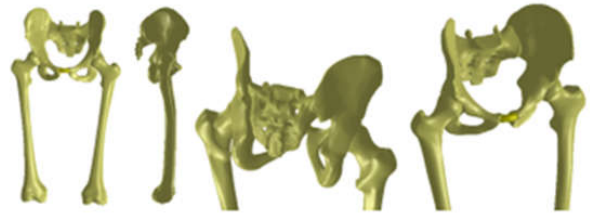
Figure 31. Final geometry of the intact hip joint in SolidWorks.